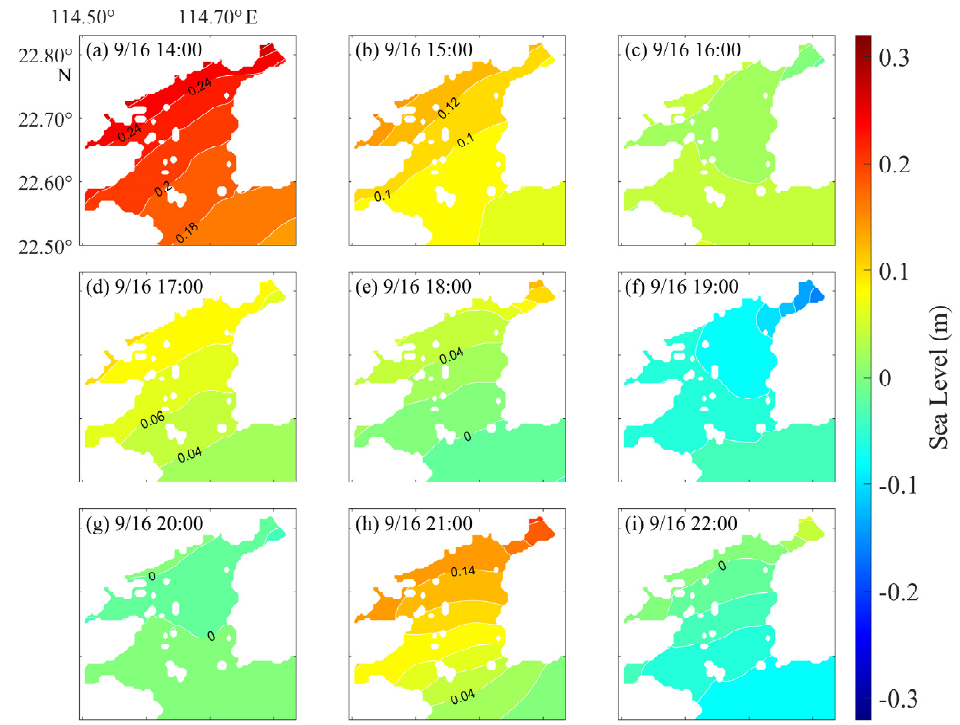
Figure 8. Distributions of instantaneous sea levels produced by the inner sub-model in Daya Bay at nine different times ( a – i ) between 14:00 and 22:00 on 16 September 2018 after the passage of Mangkhut.